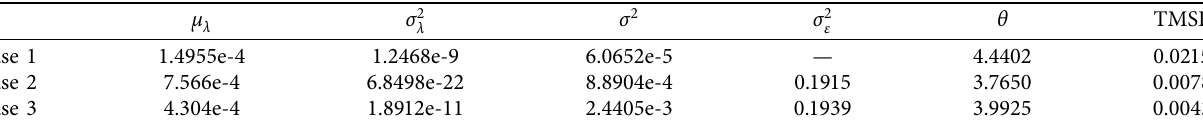
Figure 3: Illustration of the iterative convergence using the EM parameter estimation of case 3. Table 2: Comparison of three cases with the fatigue crack propagation